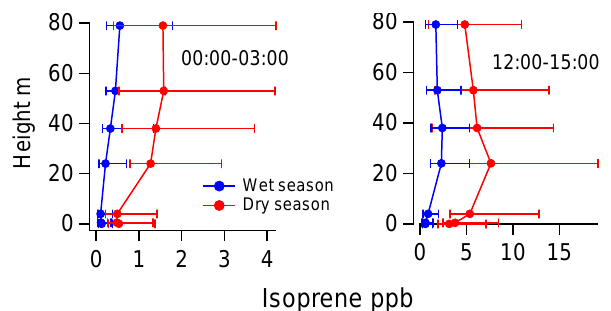
Figure 5. Vertical profiles for isoprene mixing ratios. Data are pre- sented as medians over a period of 3h between 00:00 and 03:00LT (left) and 12:00 and 15:00LT (right) (both local time). The 3h me- dians are shown in red for the dry season and in blue for the wet season. Range bars represent the 25 and 75%